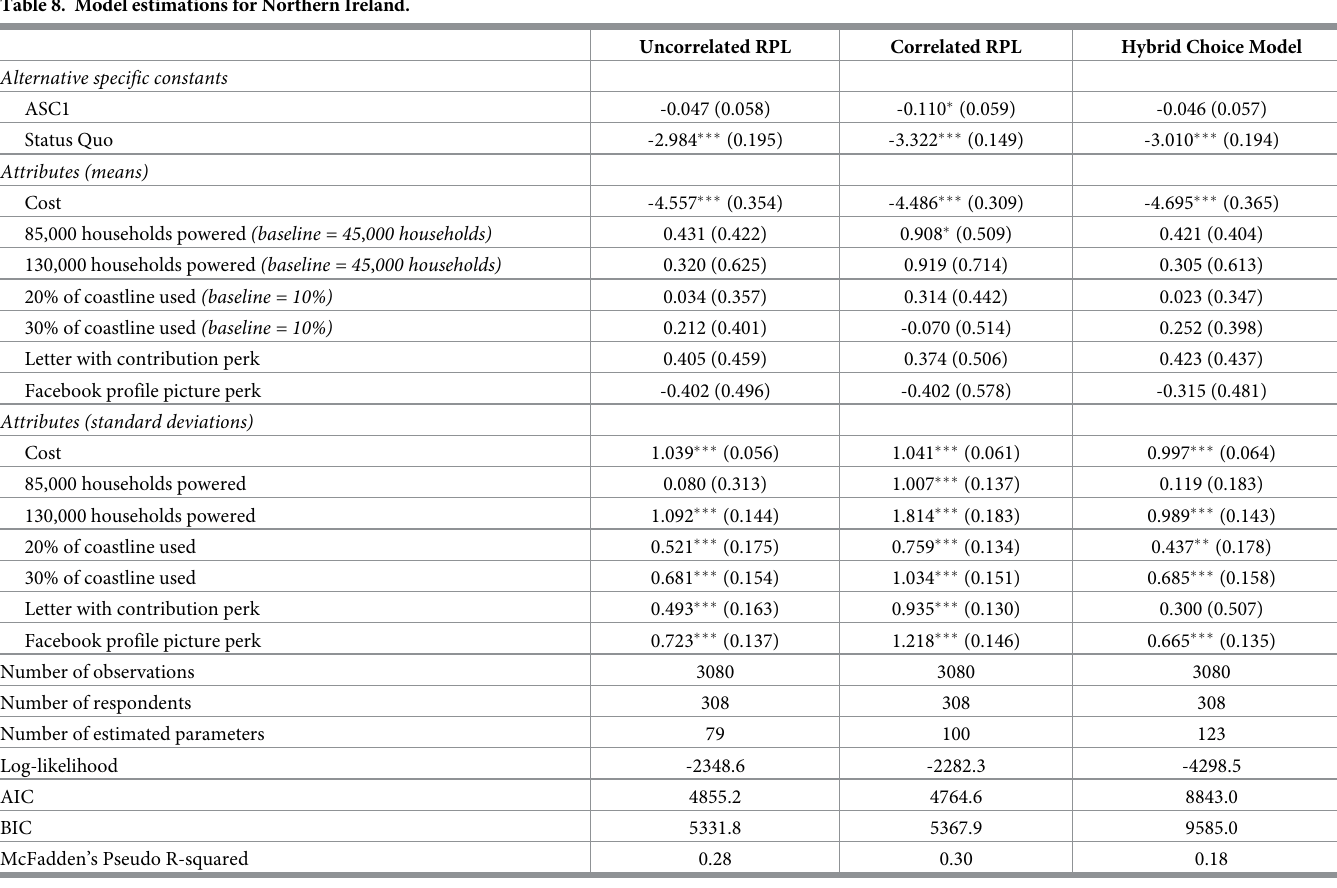
Table 8. Model estimations for Northern Ireland.